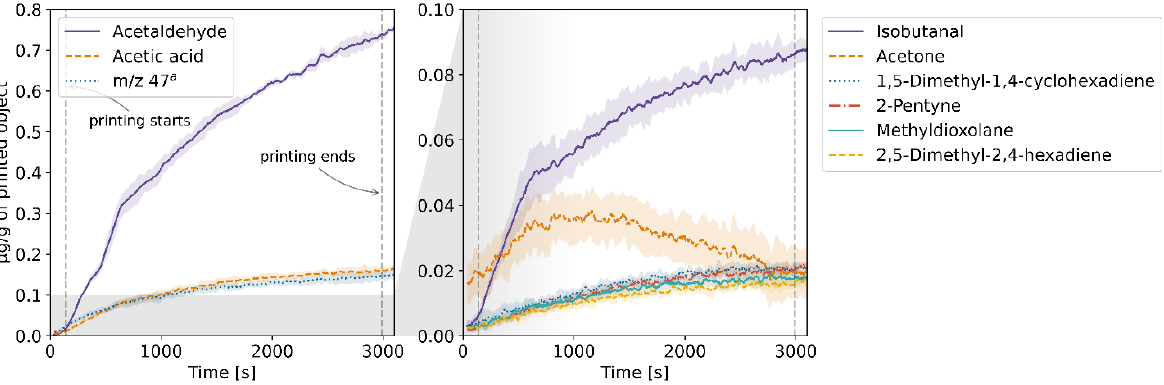
Figure 8. The mixing ratio of main VOCs within the enclosure during FFF 3D printing with the PETG filament. a see Figure 7 caption.